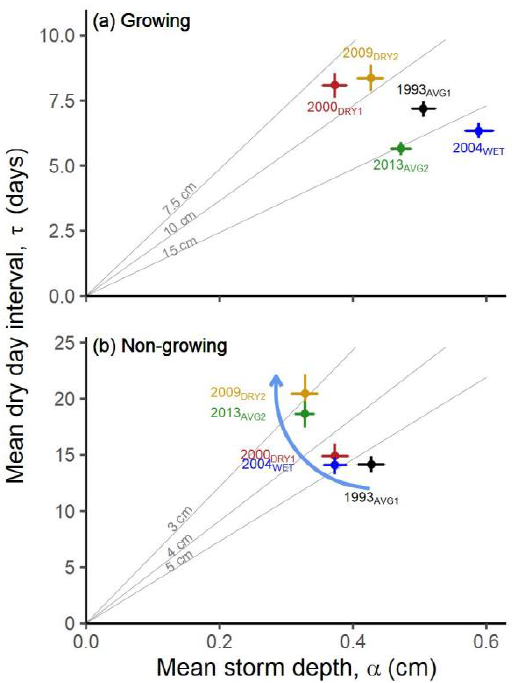
Figure 11. Mean storm depth ( α ) and mean dry-day interval ( τ ) combinations for the five periods during ( a ) growing season and ( b ) nongrowing season. Points indicate median estimated parameter values, and error bars indicate 95% confidence interval for the estimate. Periods are labeled with the first year in the period. Gray oblique lines represent α and τ combinations that result in equal mean seasonal total PPT.